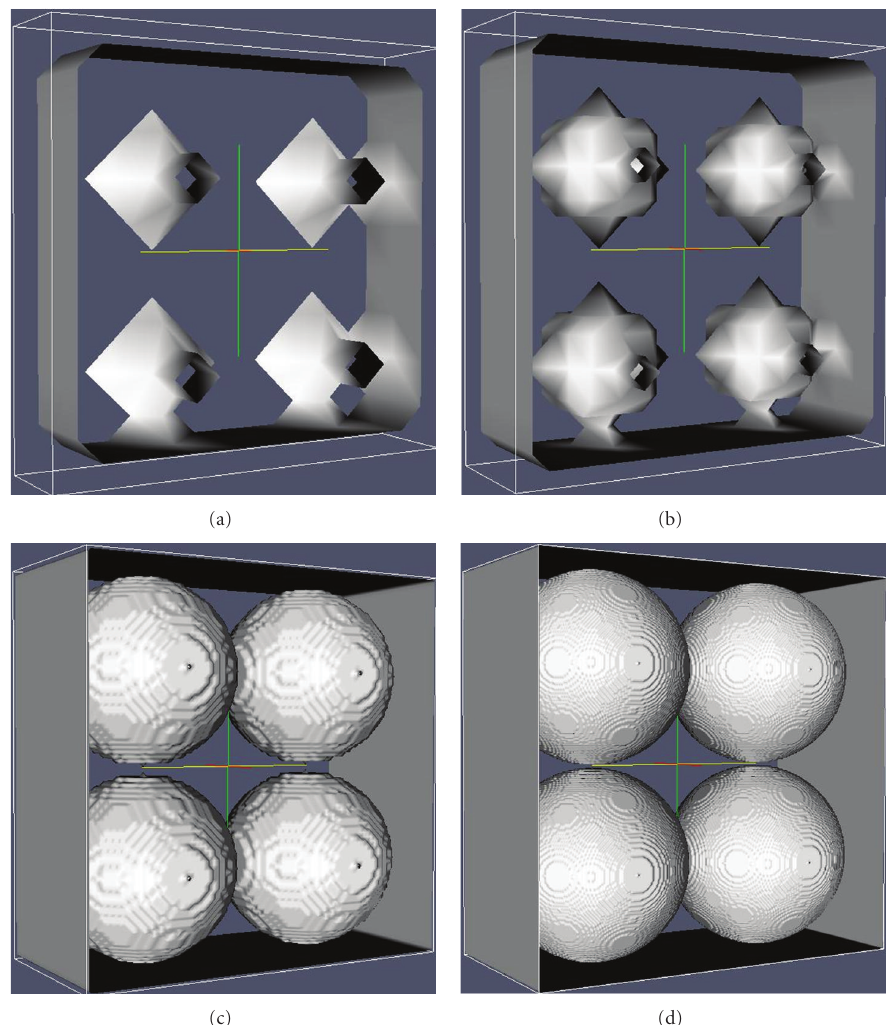
Figure 3: Media built with one solid layer (SL) of four spheres (a) D = 1, (b) D = 5, (c) D = 41, and (d) D = 121. The flow occurs coming in (or out) the